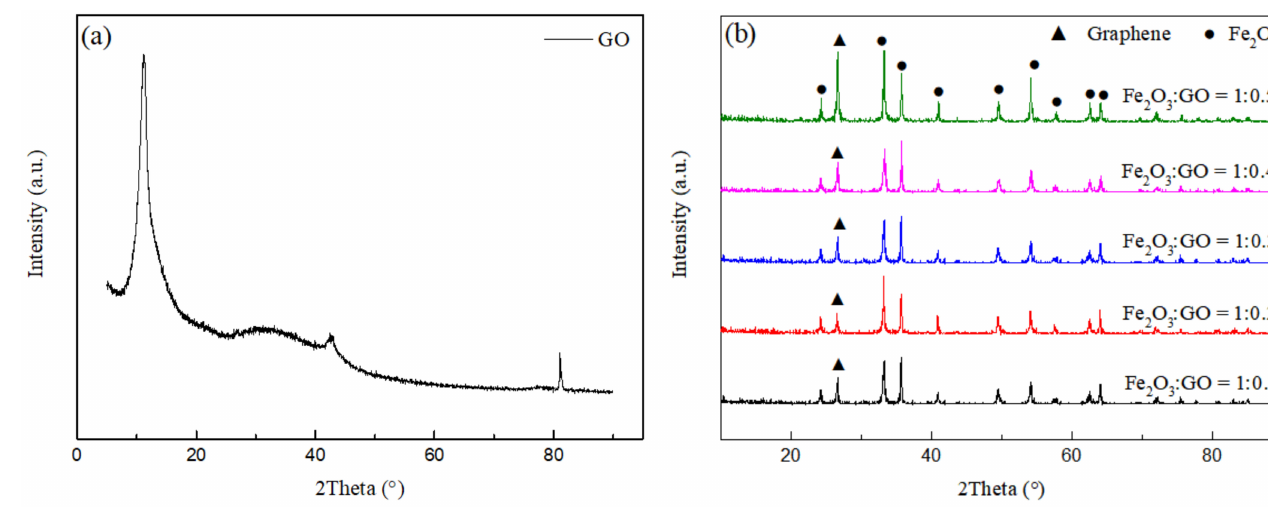
Figure 4. XRD patterns of ( a ) GO and ( b ) rGO/Fe 2 O 3 -175 ◦ C with different graphene